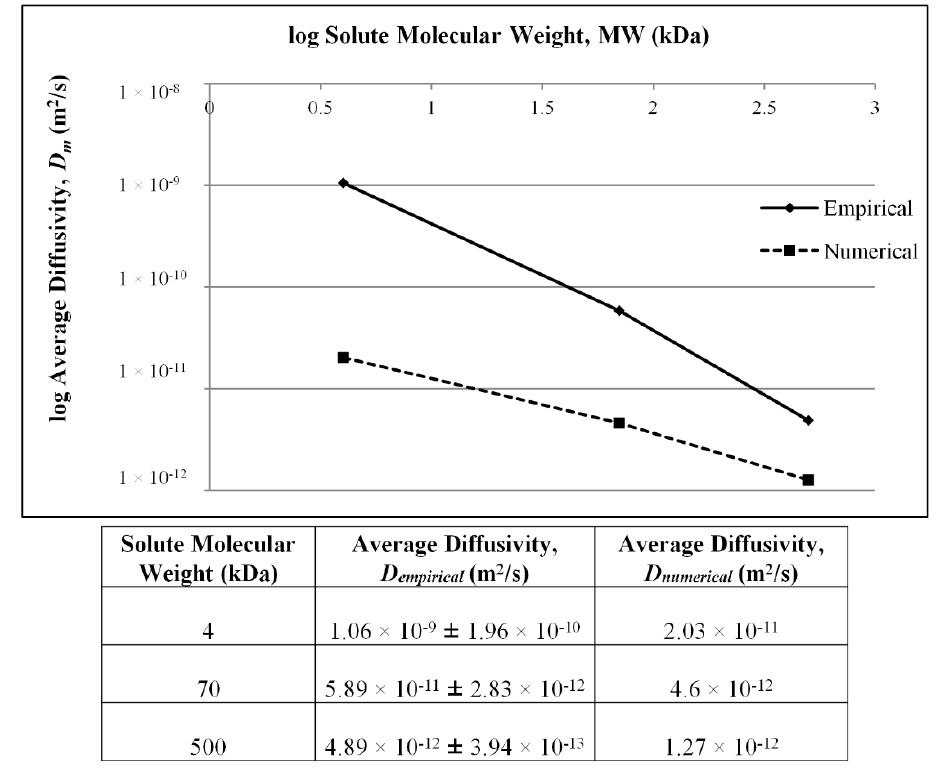
Figure 3. Summary of computed diffusivities for MW markers using the empirical ( D empirical ) and numerical methods ( D numerical